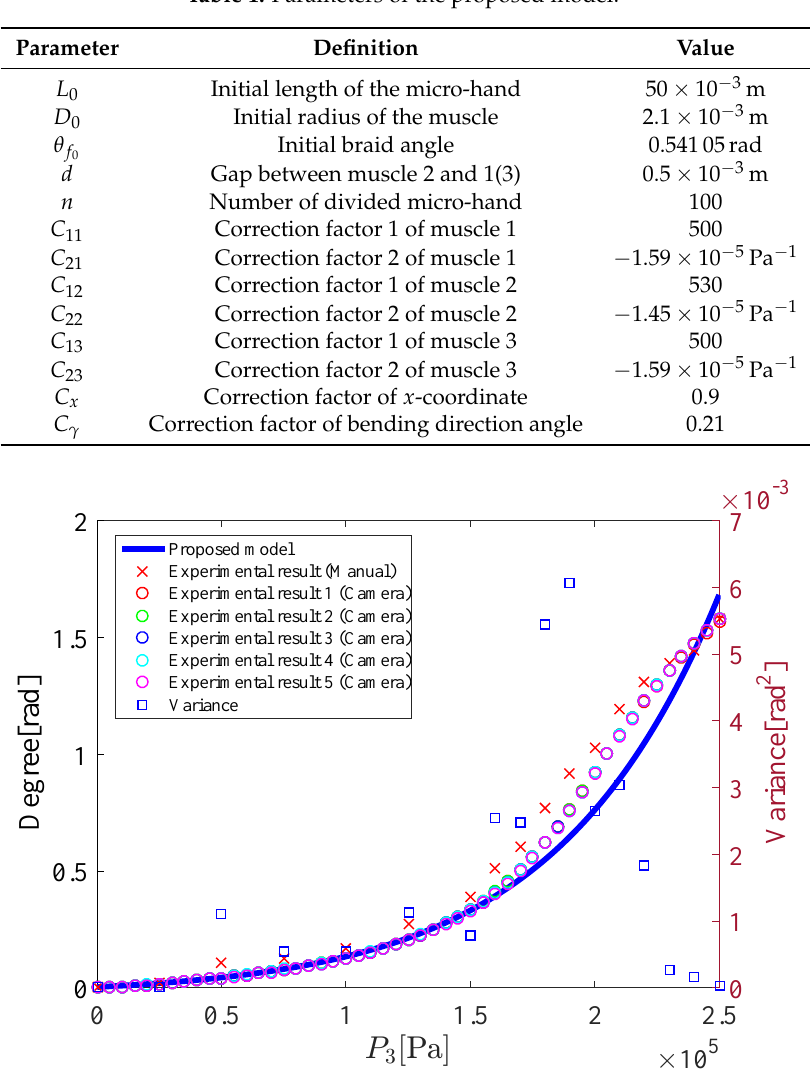
Figure 13. Bending angle ( P 1 = P 2 = 0kPa, P 3 = 0 kPa–250